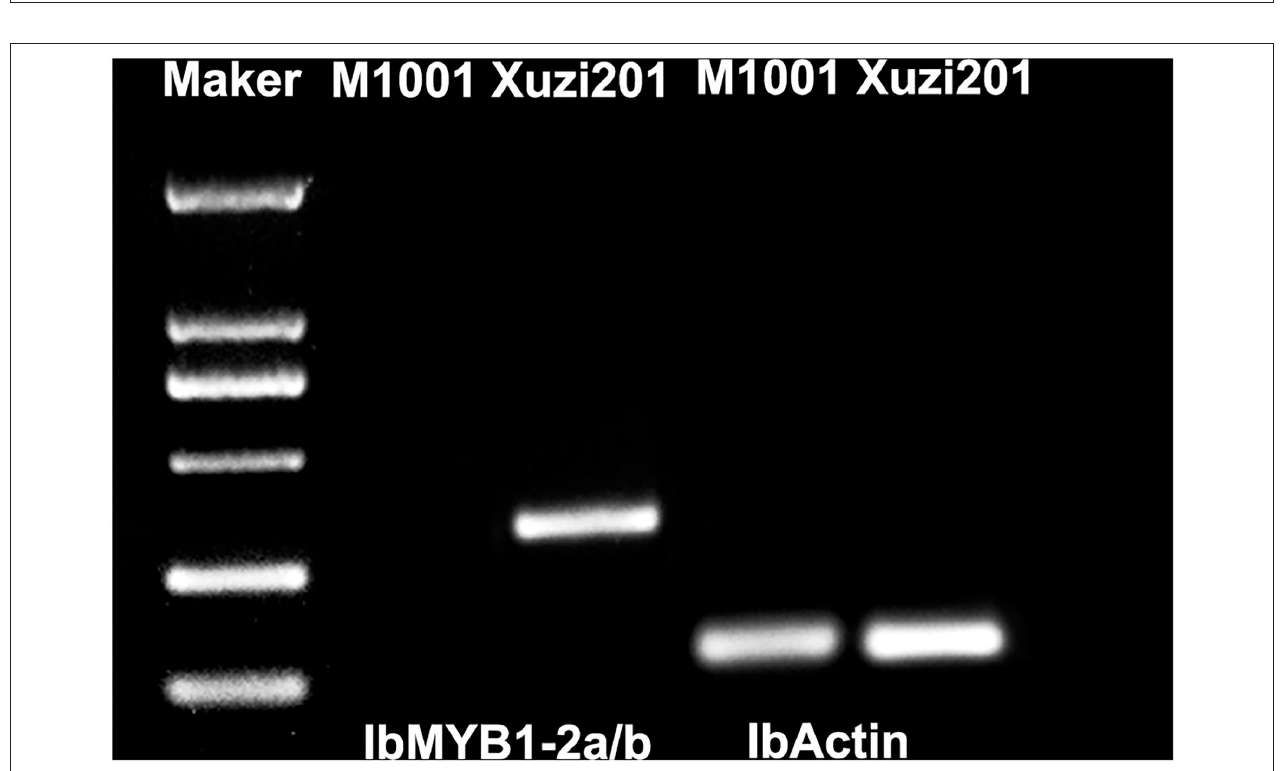
FIGURE 7 | Genotype of IbMYB1-2a/b in Xuzi201 and M1001. X201 and M1001 presented Xuzi201 and M1001, respectively.